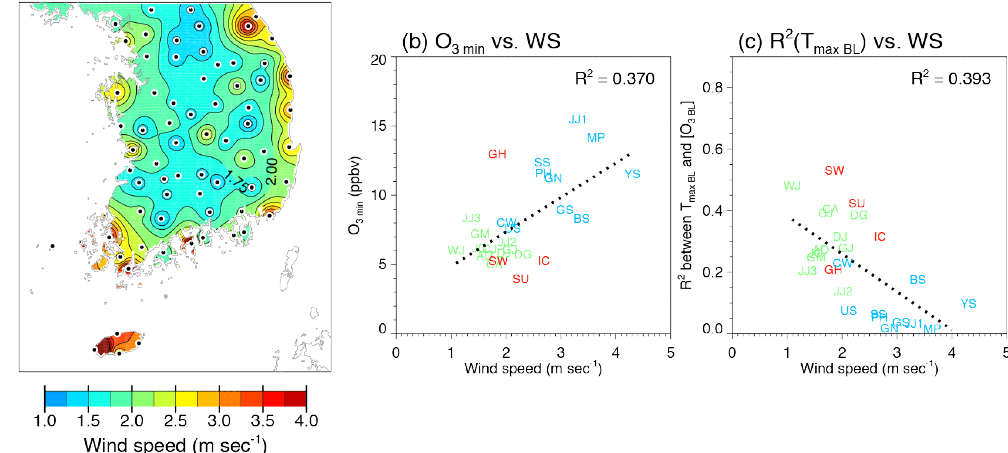
Figure 7. (a) Spatial distribution of 12yr averaged daily average WS for the period 1999–2010 using data from 72 weather stations (black dots) of KMA. (b) Scatter plot of O 3min vs. WS at 25 cities. (c) Scatter plot of R 2 between [O 3BL ] and T maxBL vs. WS at 25 cities. City codes in red, green, and blue indicate the SMA, inland, and coastal cities, respectively.